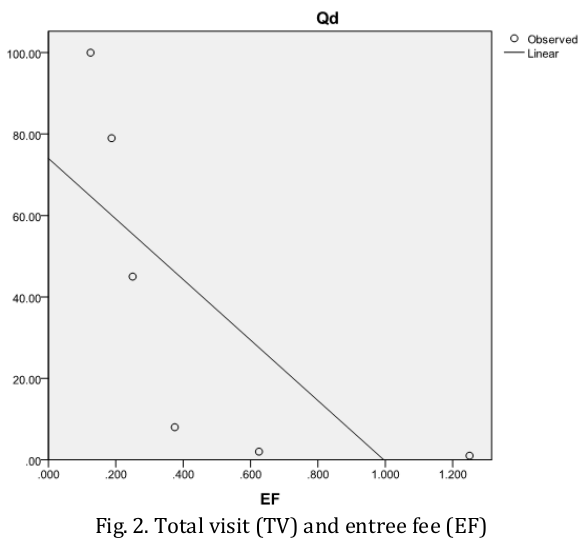
Fig. 2. Total visit (TV) and entree fee